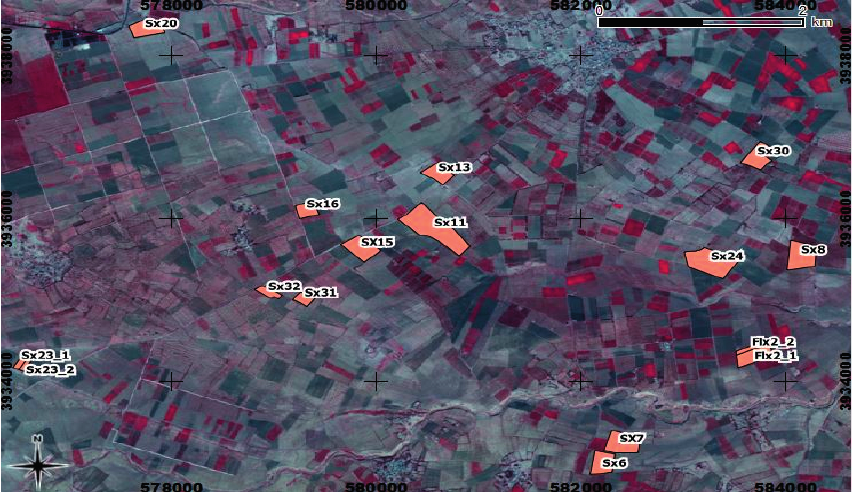
Figure 2. Location of reference fields on the study site (SPOT